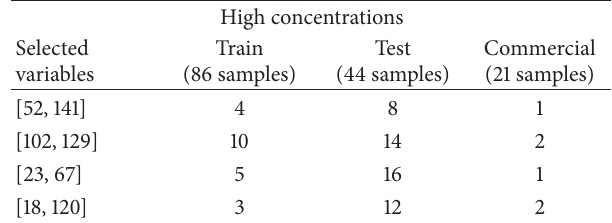
Table 10: Classification Errors using GA + ANN: high concentra- tion.